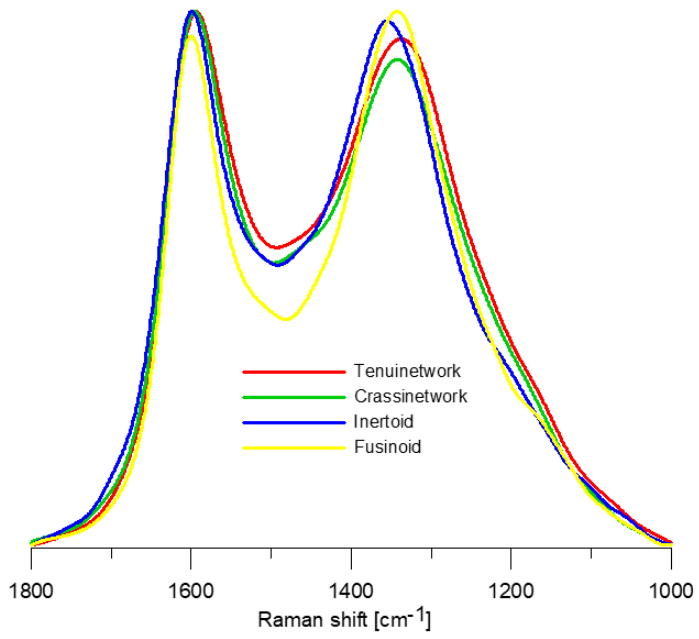
Figure 2. Representative Raman spectra of the investigated morphotypes.